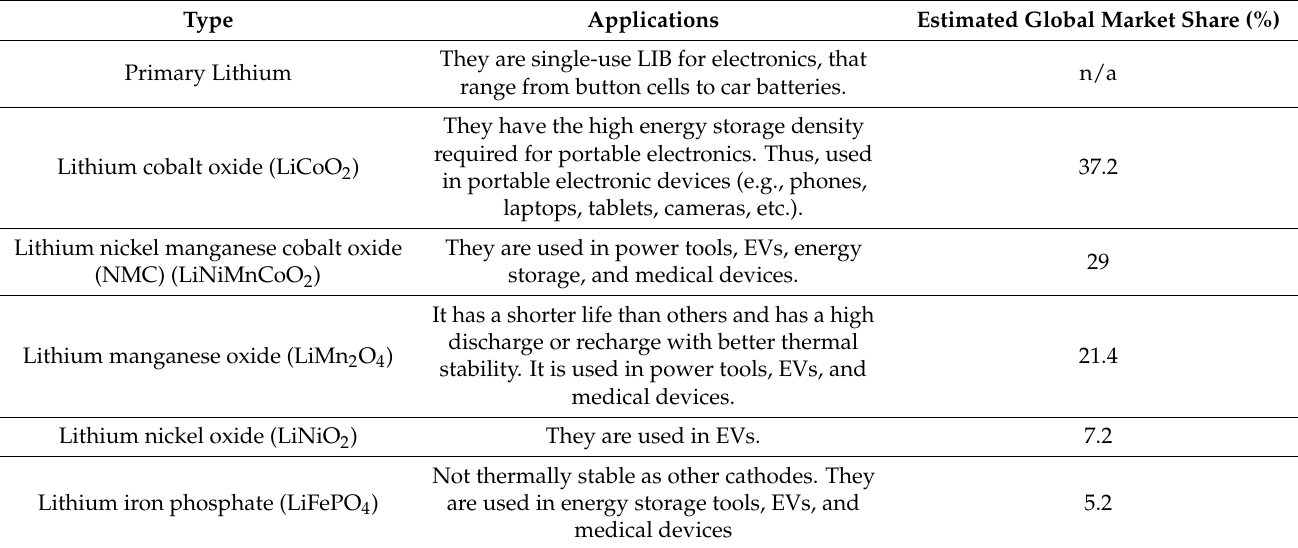
Table 1. Applications of different Lithium-ion batteries. Adapted from [43,46].